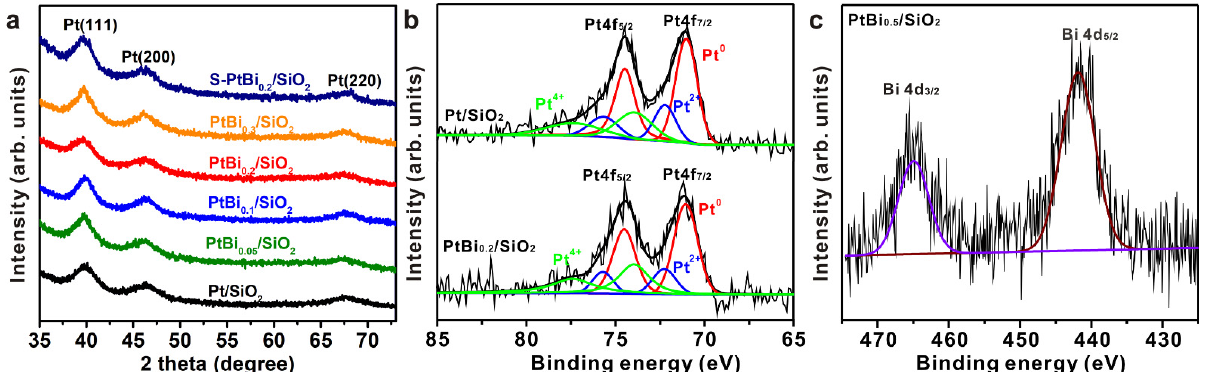
Figure 4. ( a ) XRD patterns of fresh and spent Pt/SiO 2 and PtBi x /SiO 2 catalysts, the S-PtBi 0.2 /SiO 2 (acquired after the 100-h long-term stability test); ( b ) Pt 4f XPS spectra of Pt/SiO 2 and PtBi 0.2 /SiO 2 ; ( c ) Bi 4d XPS spectrum of PtBi 0.5 /SiO 2 .